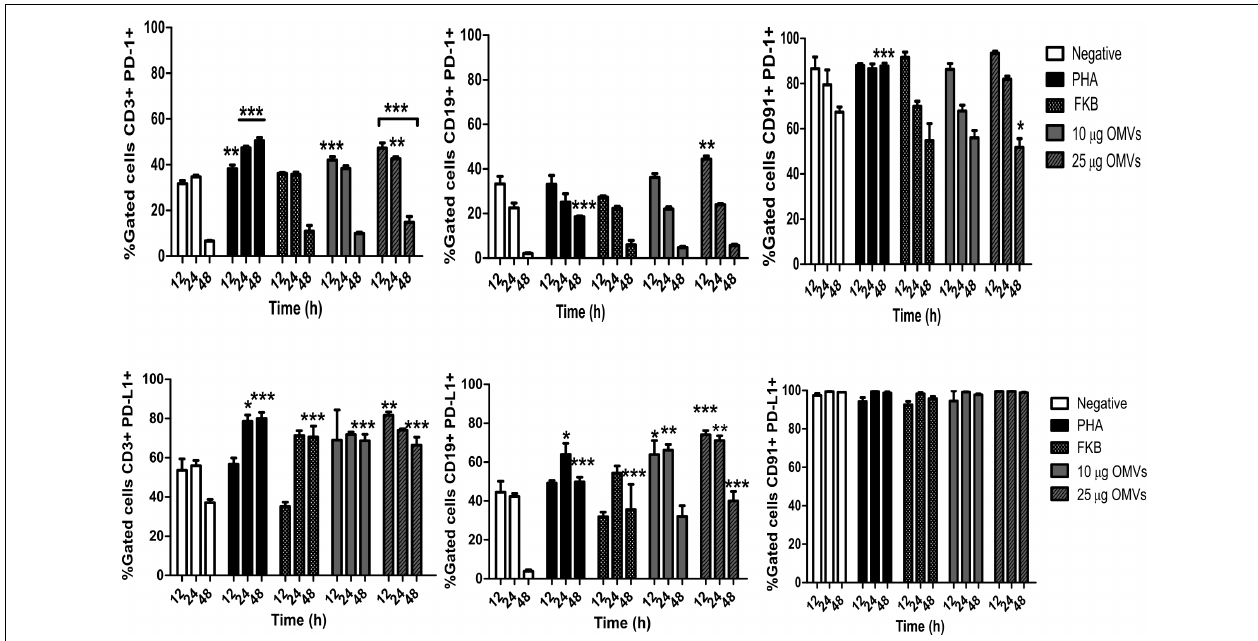
FIGURE 4 | Analysis of expression of inhibition surface markers in PBMCs stimulated with A. hydrophila ATCC R (cid:13) 7966 TM OMVs. PBMCs from healthy donor were co-cultured with OMVs from A. hydrophila . Inhibition was measured by flow cytometry using mAbs against surface molecules (PD-1, PD-L1). Monocyte (CD91 + ) and lymphocytes (CD3 + , CD19 + ) were gated to analyze individually the expression of surface molecules. FKB were used as control for the expression of surface markers. ∗ P < 0.05, ∗∗ P < 0.01, ∗∗∗ P <